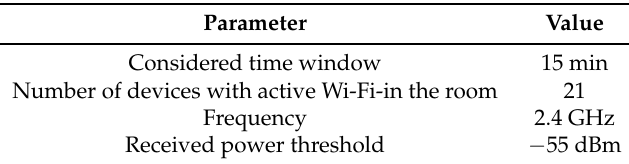
Figure 6. Percentage of received Probe Request frames with respect to their receiving power. Table 3. Parameters of the experiments for the evaluation of the accuracy performance of the de-randomization algorithm.